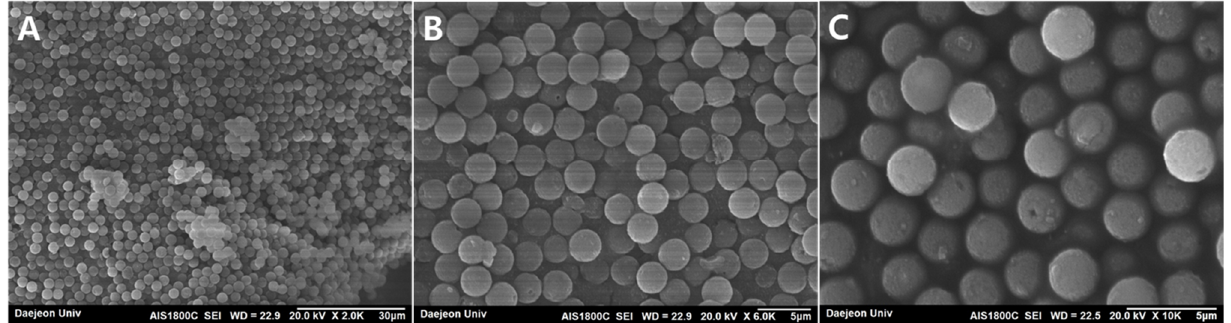
Figure 5. SEM images of microparticles of the bottom portion of PEG-DEX ATPS after the EDC coupling reaction with different magnifications. ( A ) 2000 times, ( B ) 6000 times, ( C ) 10,000 times magnified. Scale bars are ( A ) 30, ( B ) 5, ( C ) 5 μm. See Experimental for other conditions.